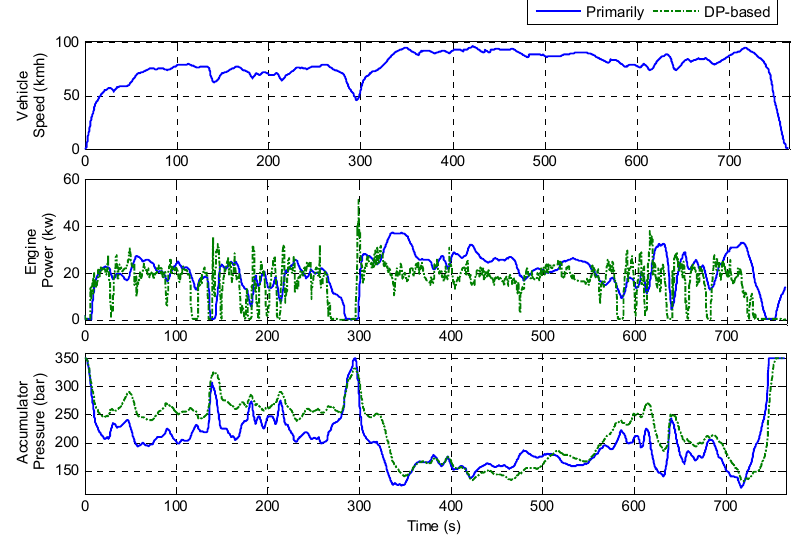
Figure 17. Pressure Trajectories with Primary and DP ‐ Based Modulated ‐ Pressure Strategies.